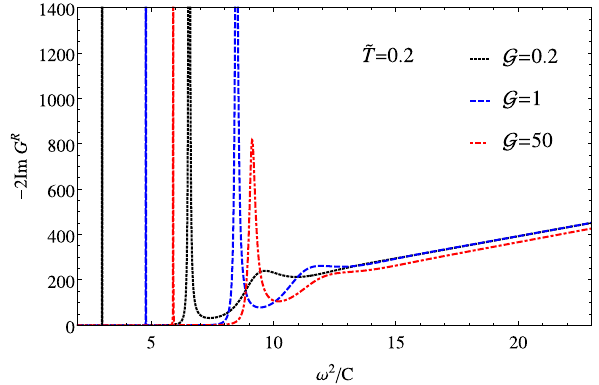
Fig. 7 The spectral functions with zero wavenumber for G = 0 . 2, G = 1 and G = 50. These results were obtained for (cid:10) T = 0 . 2